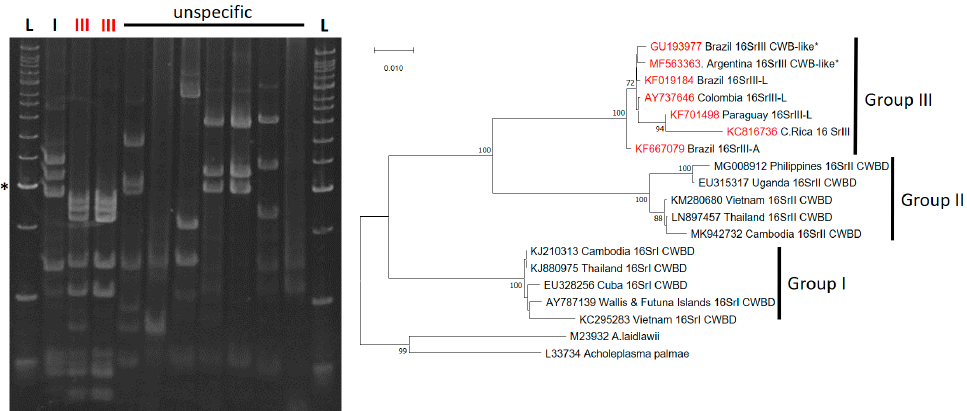
Figure 5. Phytoplasmas detected in CFSD-affected plants belong to the 16Sr ribosomal group III (in red). Restriction analysis ( left ) of the 16S RNA region amplified by nested PCR. Phylogenetic analysis of the 16Sr sequences of phytoplasmas isolated from cassava ( right ) in the Americas (in red) and Southeast Asia. L = Ladder. CWBD = cassava witches’ broom disease. L = DNA Ladder (Bioline, USA). The asterisks indicates the 300 bp band.